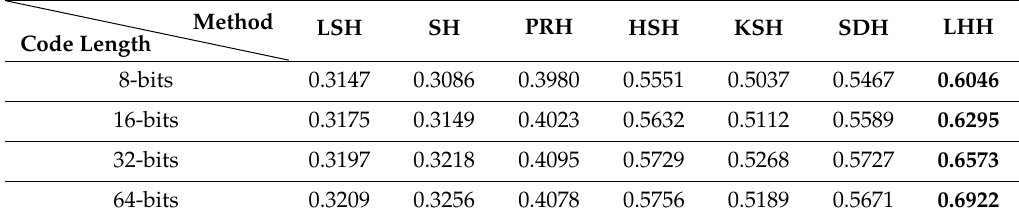
Table 4. Comparison of mAP with di ff erent hash code lengths on SAT4.